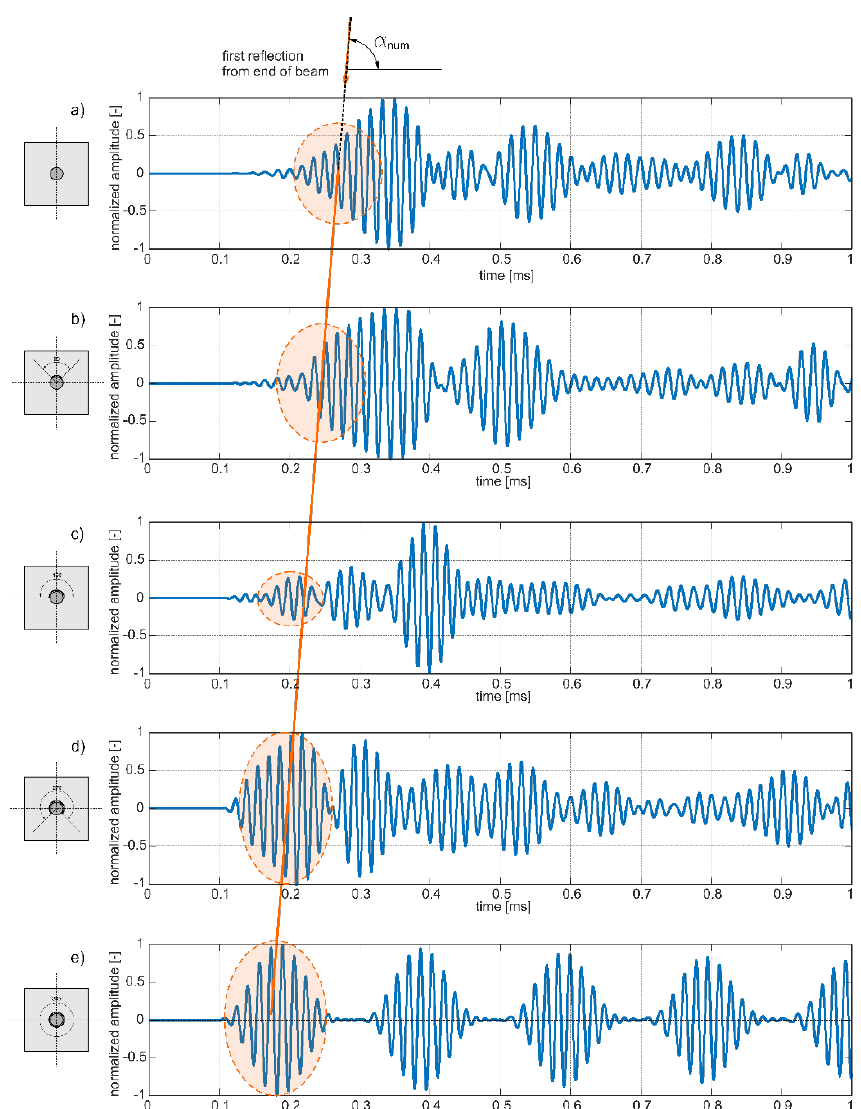
Figure 12. Numerical wave propagation signals registered at the end of the beam with variable circumferential debonding extent: ( a ) undamaged beam and beam with debonding extent of ( b ) 90°, ( c ) 180°, ( d ) 270°, and ( e ) 360° for excitation frequency 60 kHz.